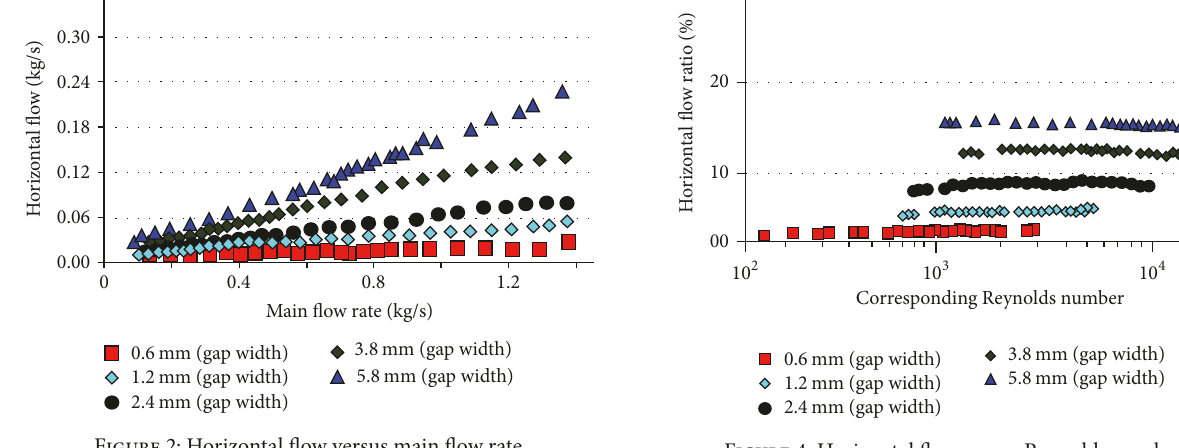
Figure 4: Horizontal flow versus Reynolds number.